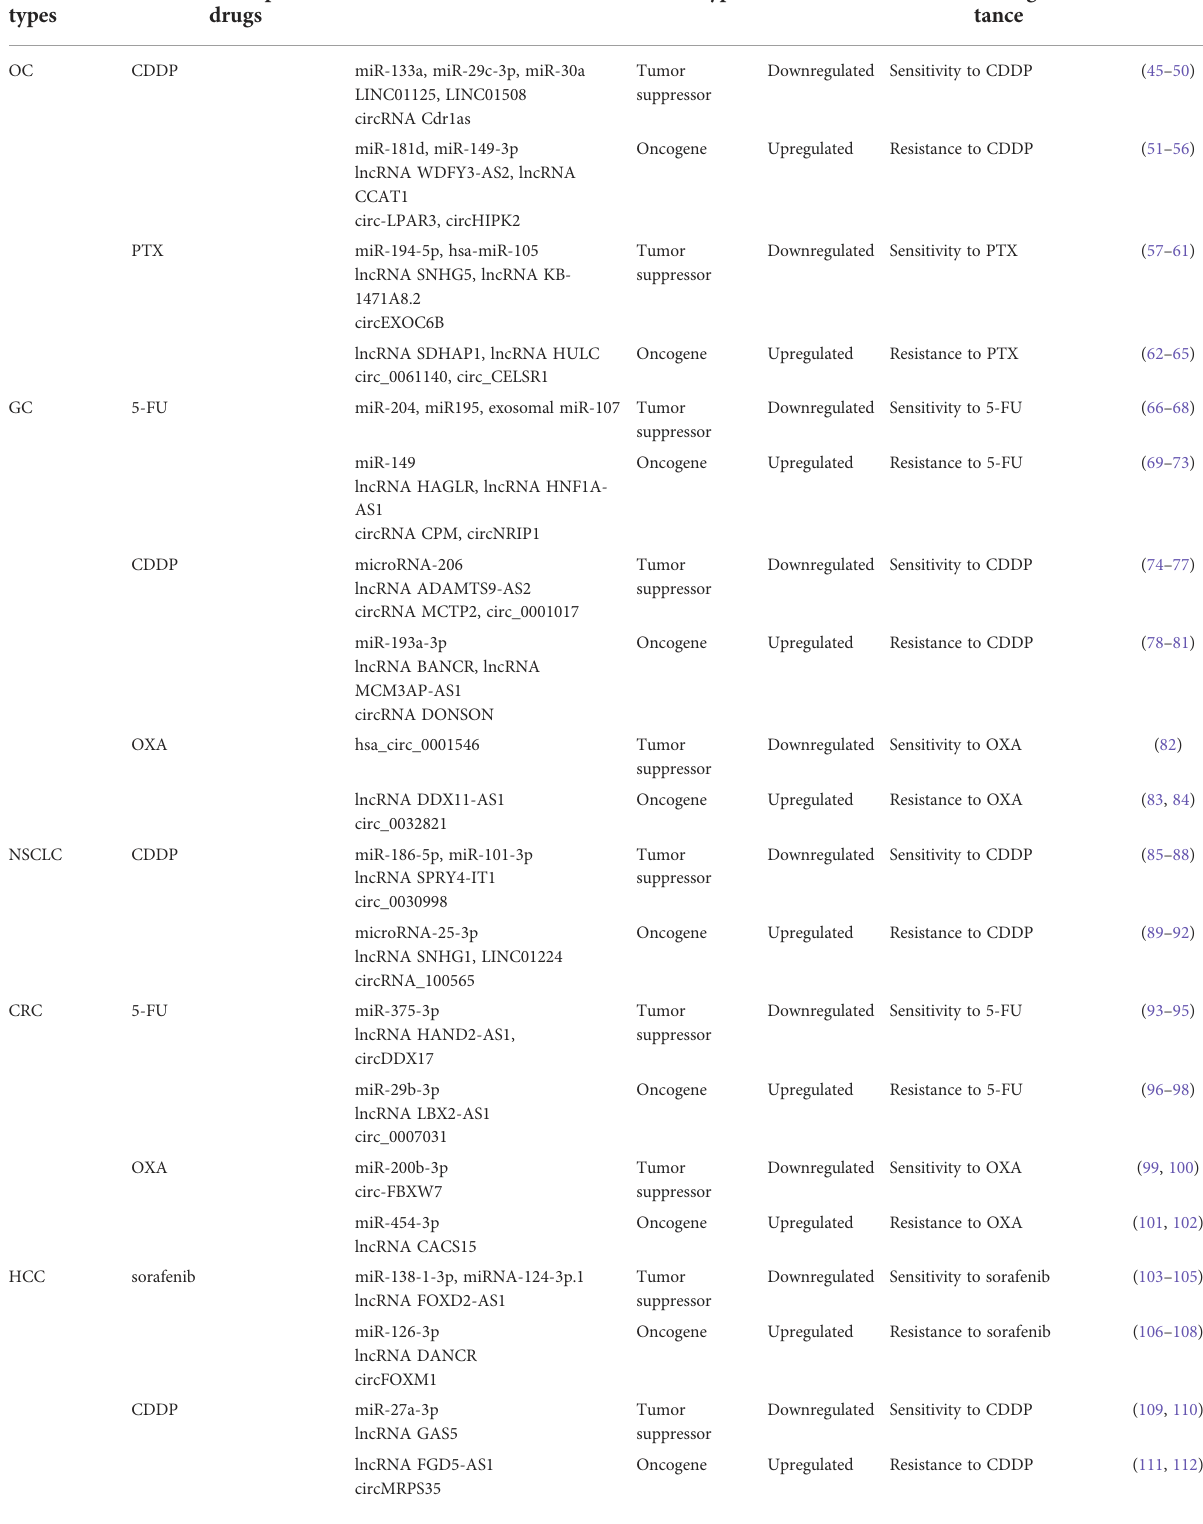
TABLE 1 Roles of ncRNAs in cancers drug